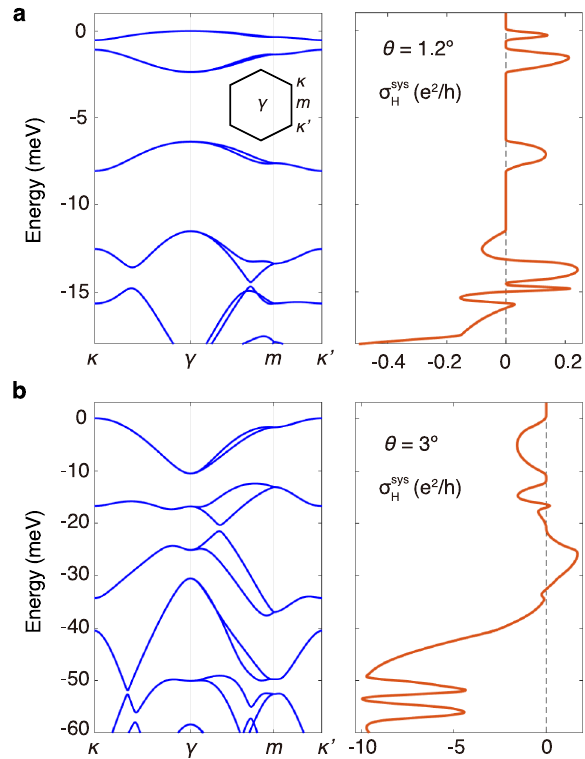
Fig. 4 | TR-even charge Hall effect in tMoTe 2 with different θ . a Results for θ =1.2 ∘ . b Results for θ =3 ∘ . In both cases, the left and right panels present the valence band structures and Hall conductivity in the system layer,